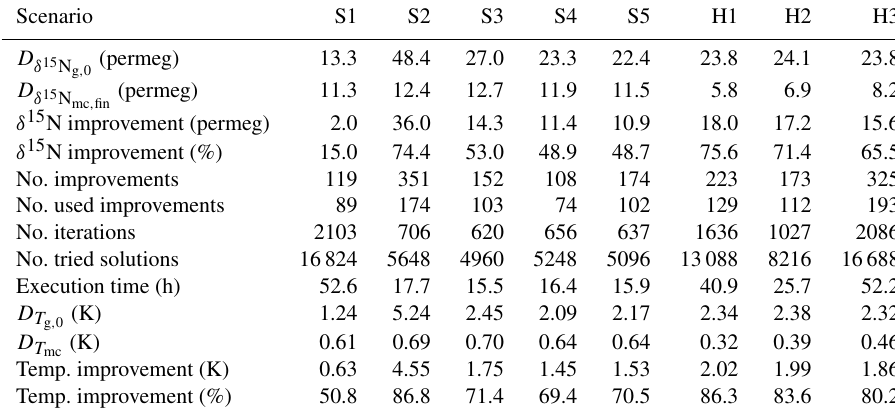
Table 2. Summary for the Monte Carlo approach: mismatch D g , 0 between the modelled δ 15 N (or temperature) values using the first-guess input and the synthetic δ 15 N (or temperature) target for each scenario. D mc is the mismatch between the modelled δ 15 N (or temperature) using the final Monte Carlo temperature solution and the synthetic δ 15 N (or temperature) target for each